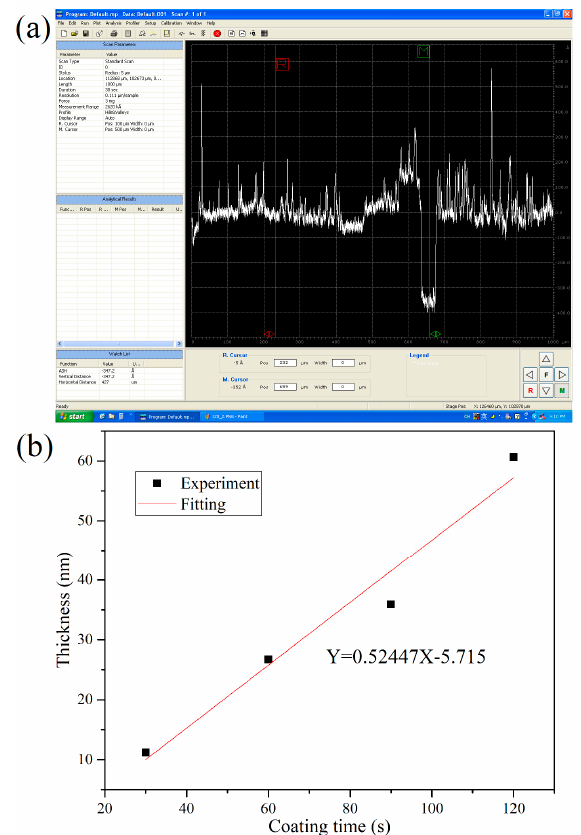
Figure 2. ( a ) Typical screenshot of the step profiler for measuring the gold film thickness with sputtering time of 90 s; ( b ) Gold film thickness as a function of sputtering time.